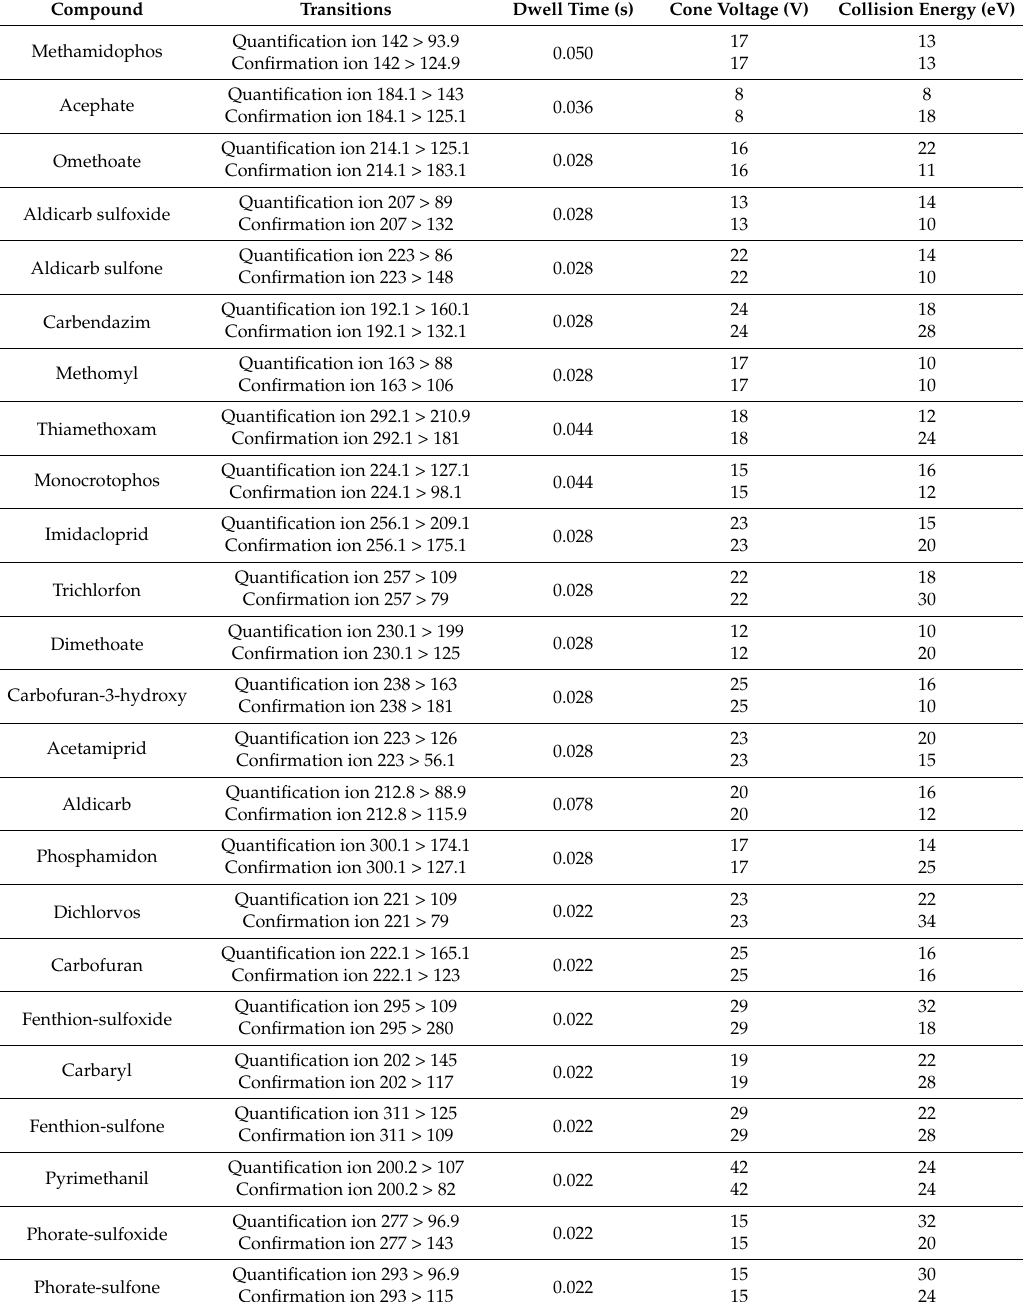
Table 6. Ion transitions used for the quantification (MRM1) and confirmation (MRM2), dwell time, cone voltages, and collision energies for